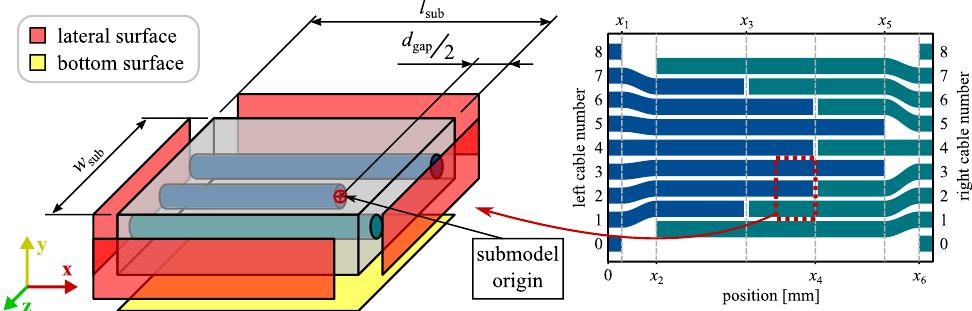
Figure 8. Sketch of the submodel, which is located in the splice. Additionally, the surfaces are defined for boundary